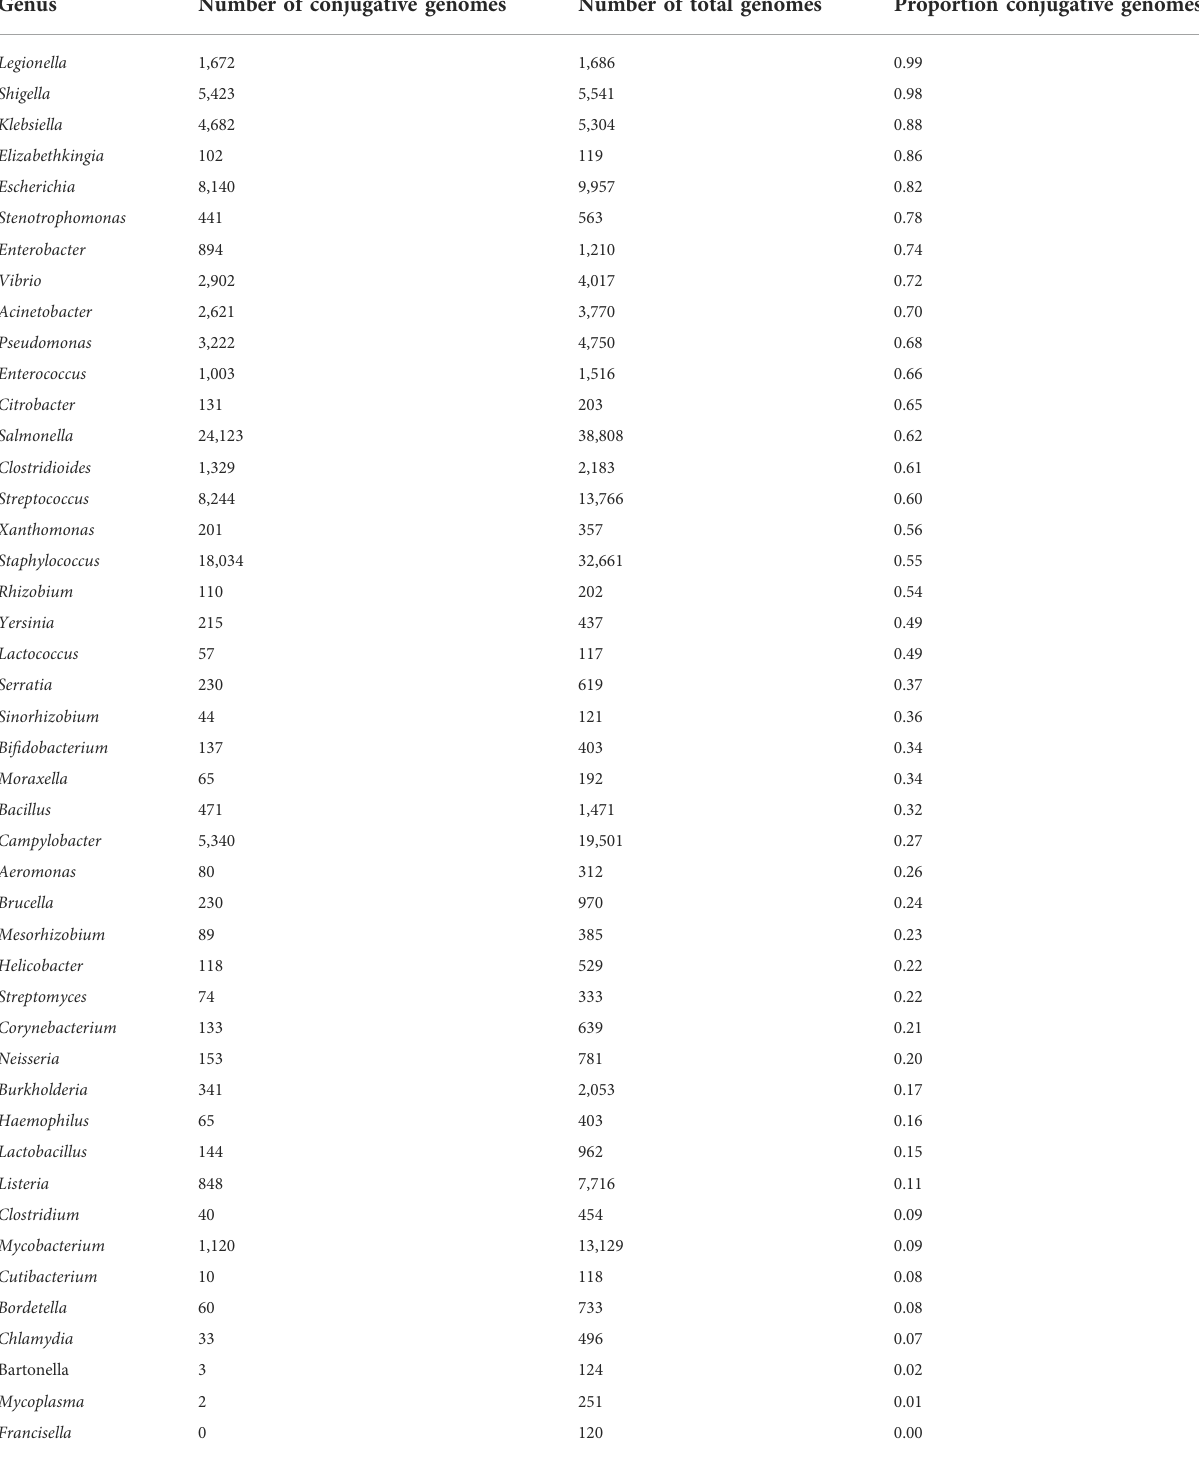
TABLE 2 Proportion of genomes that contained conjugative feature(s), by genus. All genera with over 100 representative genomes are listed, in descending order by the proportion of conjugative genomes in each genus.